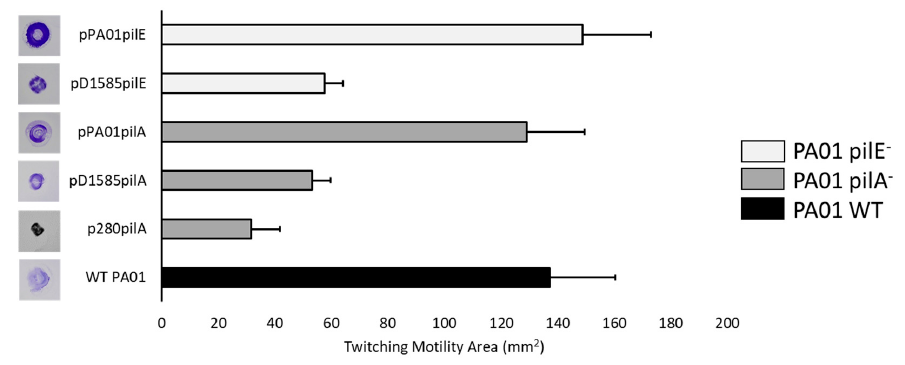
Figure 3. Twitching motility is partially restored in cross-genera complemented P. aeruginosa PA01 pilin mutants. PA01, its pilA PW8621 and pilE PA01_lux_41_C7 mutants and their respective complemented strains were stab inoculated through 1% ½ LB agar and incubated for 24 h at 37 °C. Twitching zones were visualized with 1% crystal violet and measured using ImageJ [42]. Complementation with the endogenous PA01 genes restored twitching to wildtype, while cross-genera complementation only partially restored motility. Representative twitching zones are shown on the left and the average area of the twitching zones from nine replicates are shown on the right including error bars showing standard